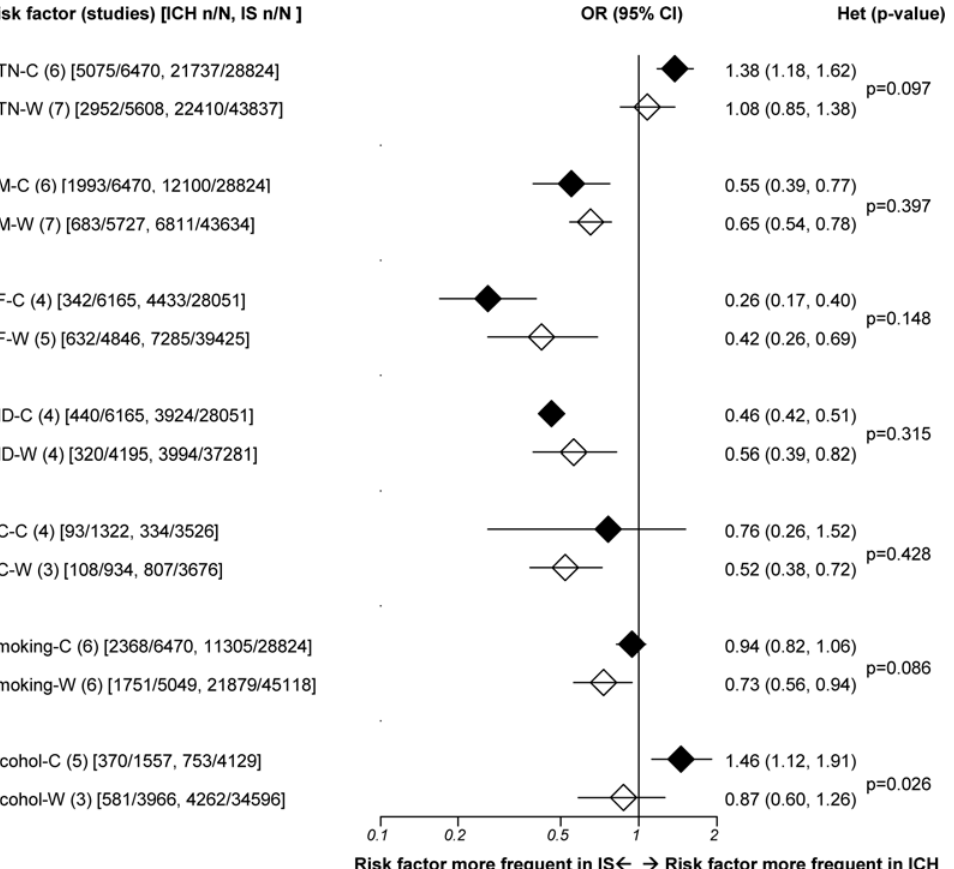
Fig 5. Risk factor meta-analyses for intracerebral hemorrhage versus ischemic stroke in Chinese and white populations. ICH = intracerebral hemorrhage; IS = ischemic stroke; n = number of patients with risk factor; N = total number of patients; OR = odds ratio; CI = confidence interval; Betw group het = between-group (ethnic) heterogeneity; C = Chinese; W = Whites; HTN = hypertension; DM = diabetes; AF = atrial fibrillation; IHD = ischemic heart disease; HC = hypercholesterolemia. Diamonds represent pooled ORs. Horizontal lines represent 95%